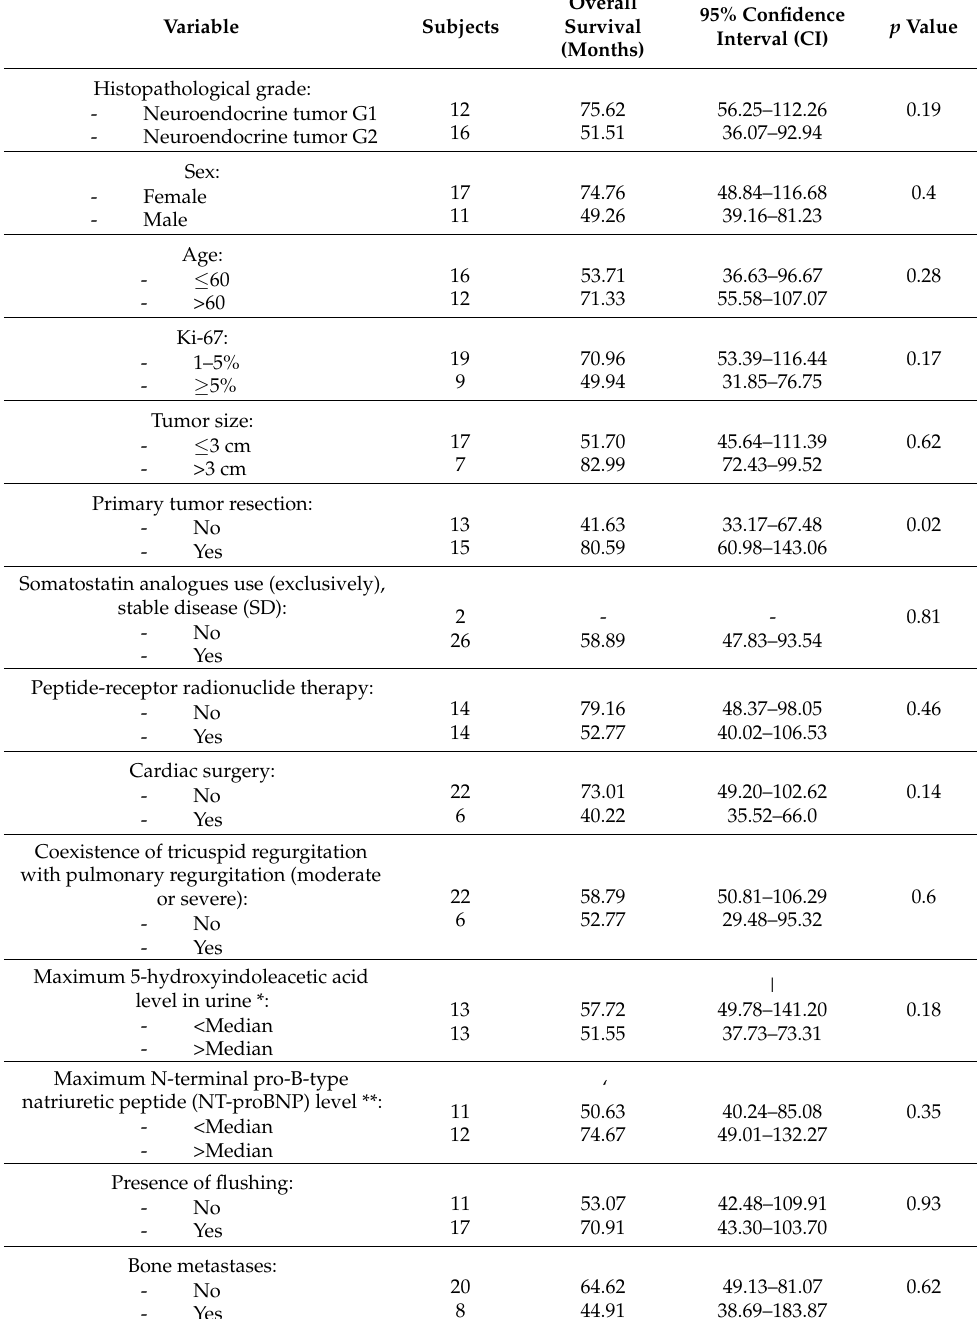
Table 4. Median OS in patients with